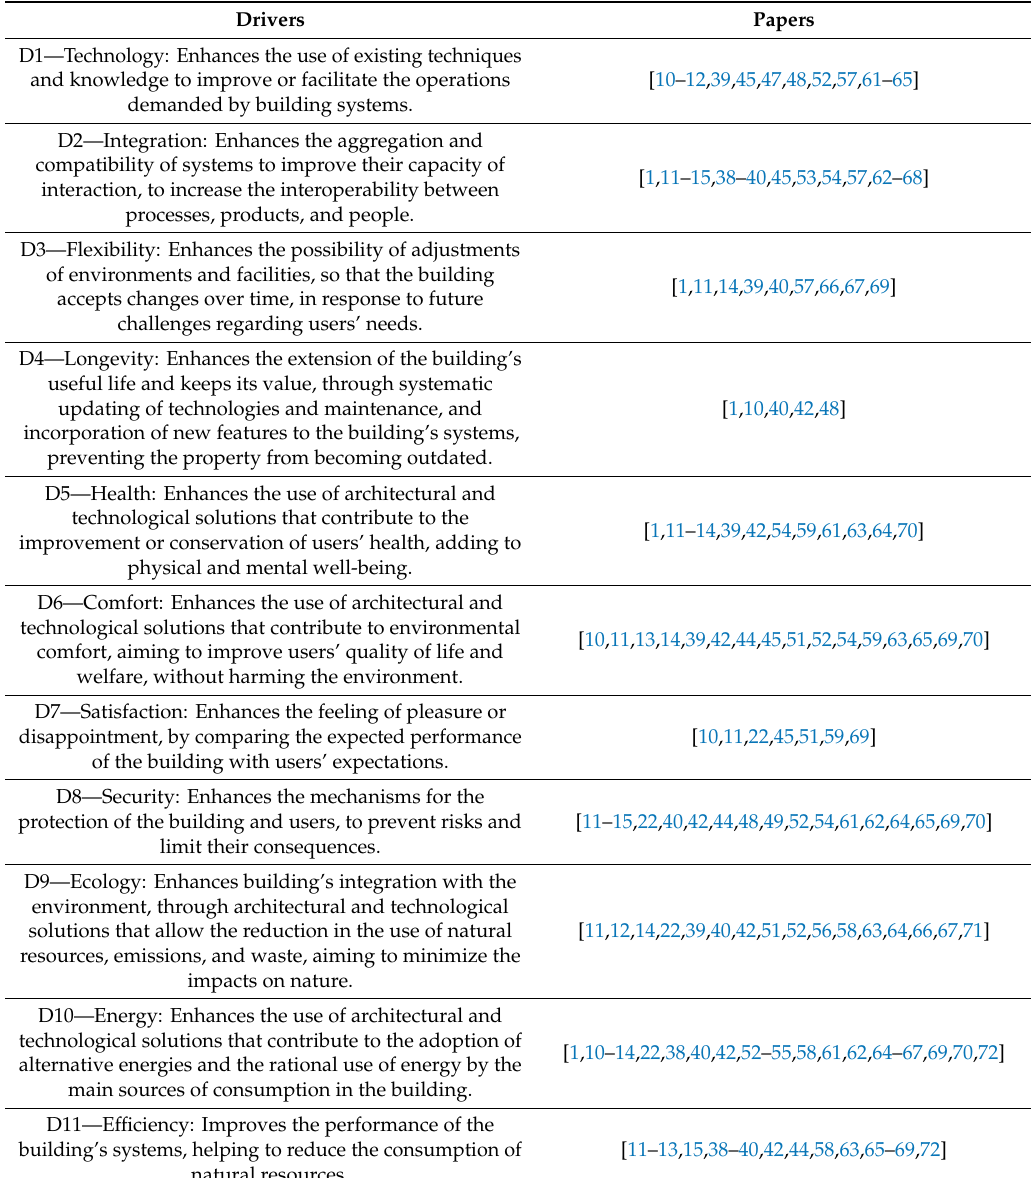
Table 1. Main drivers of smart